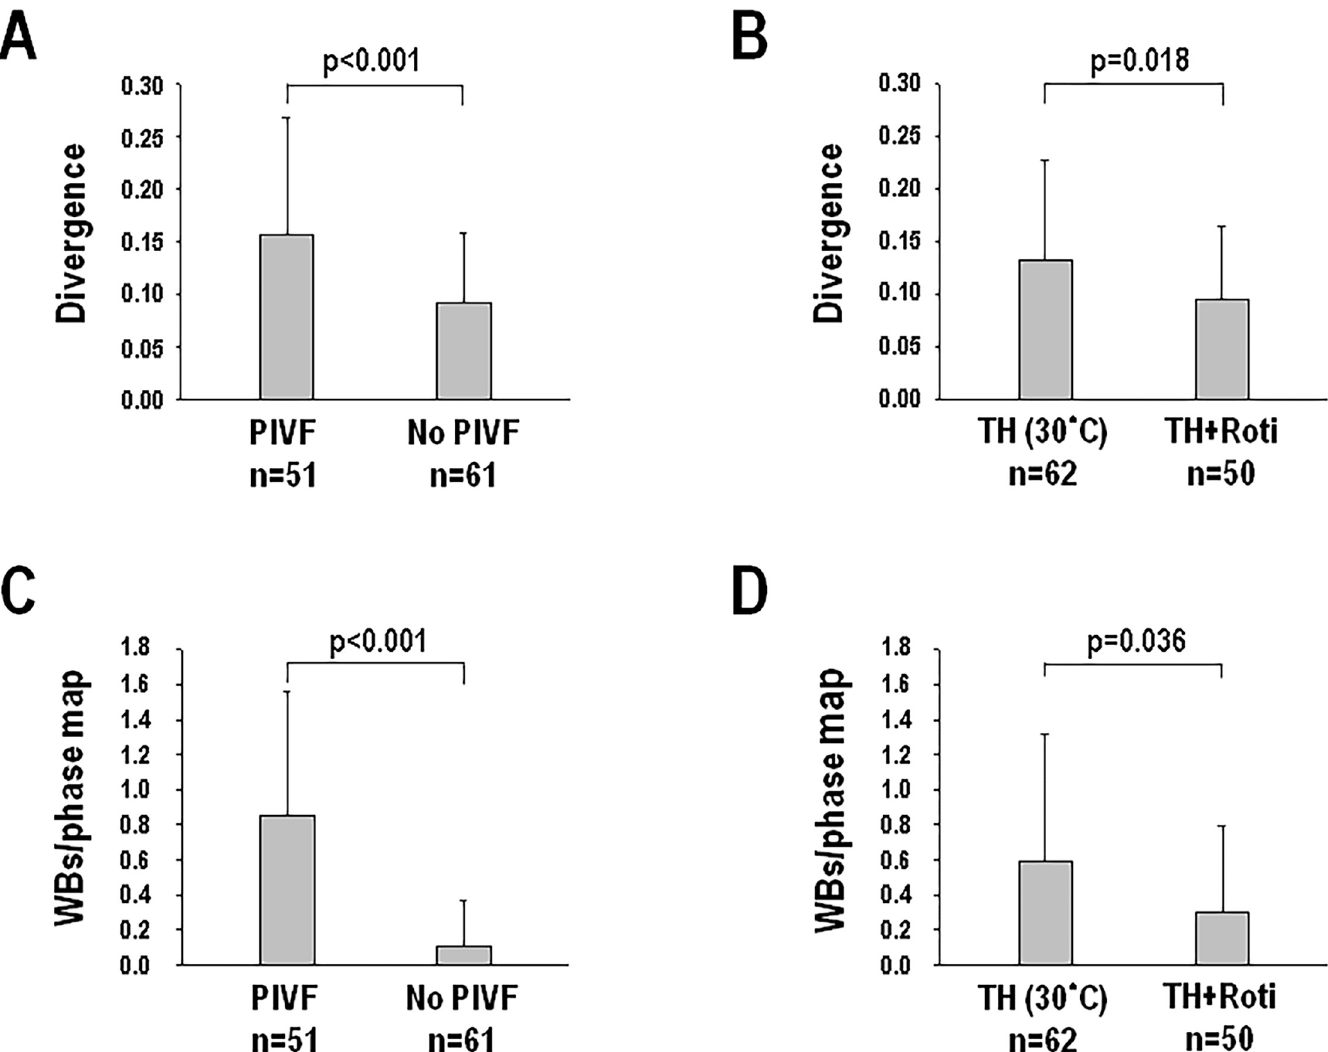
Fig 4. Ventricular divergence (A, B) and epicardial wavebreaks (C, D) in the pacing-induced ventricular fibrillation (PIVF) and non-PIVF (no VF) episodes with and without rotigaptide (Roti) infusion during therapeutic hypothermia (TH, 30˚C).